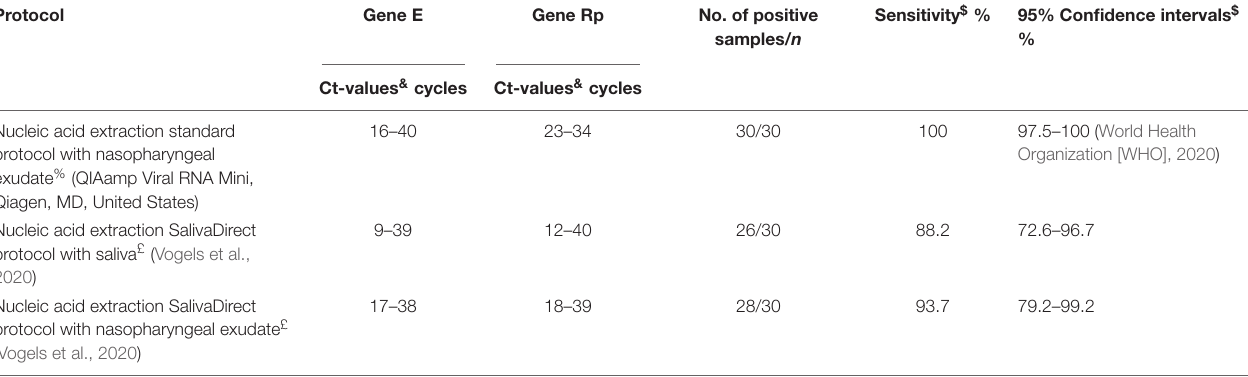
TABLE 1 | Comparison of three protocols for acid nucleic extraction of SARS-CoV-2 ( n = 30) individuals diagnosed with COVID-19 from nasopharyngeal swab and saliva clinical samples. Protocol Gene E Gene